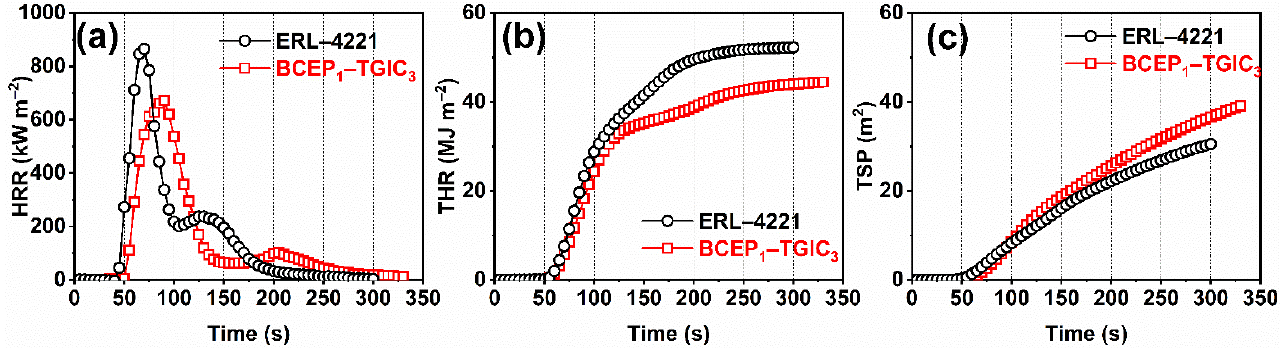
Figure 3. HRR ( a ), THR ( b ), and TSP ( c ) curves of the cured ERL-4221 and BCEP 1 -TGIC 3 recorded by the cone calorimeter. Table 3. CCT data of the cured ERL-4221 and BCEP 1 -TGIC 3 under a heat flux of 35 kW m − 2